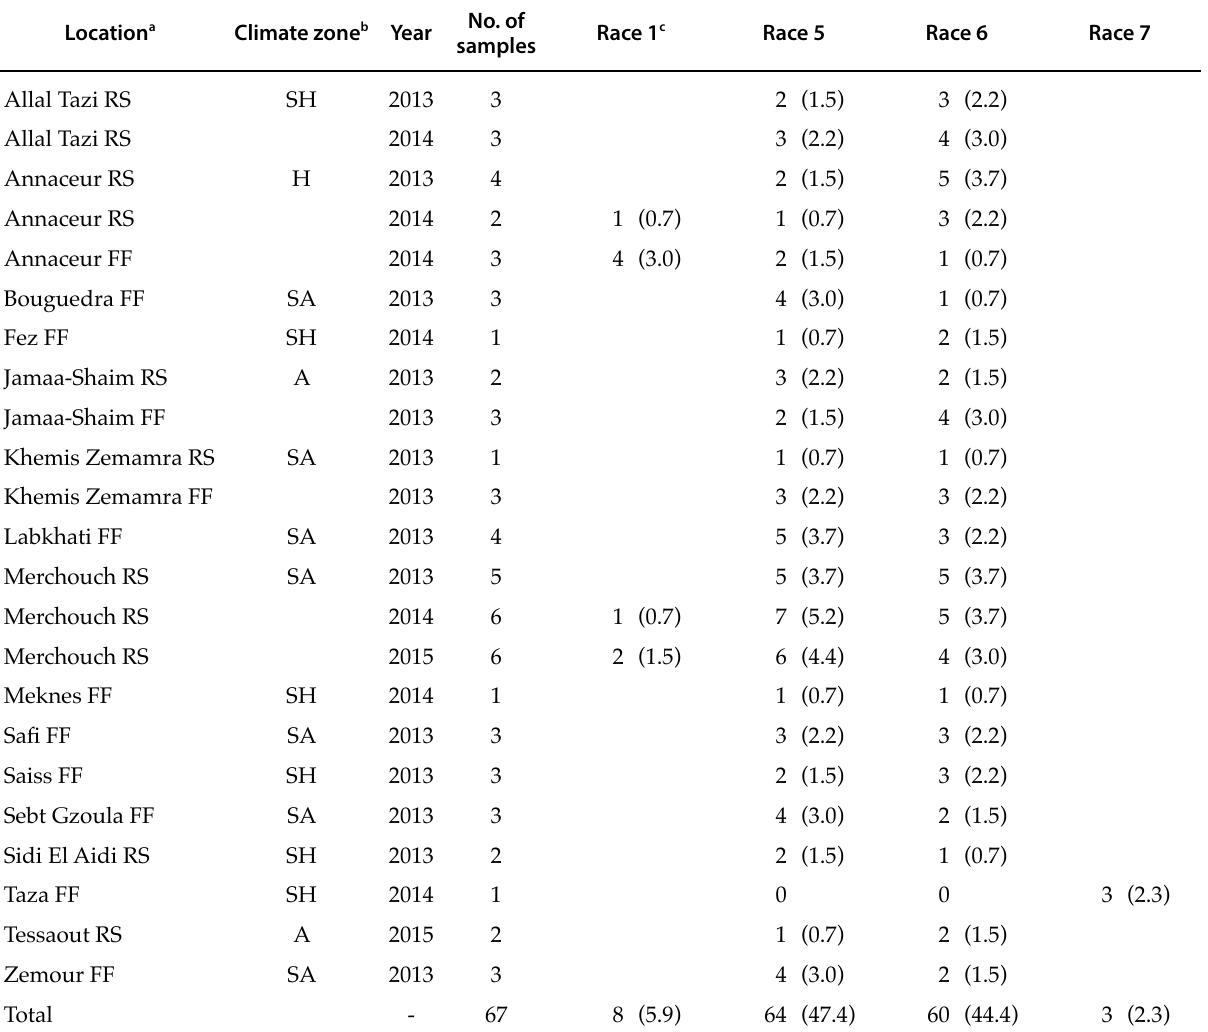
Table 2. Race composition of Moroccan populations of Pyrenophora tritici-repentis during 2013-2015. Location